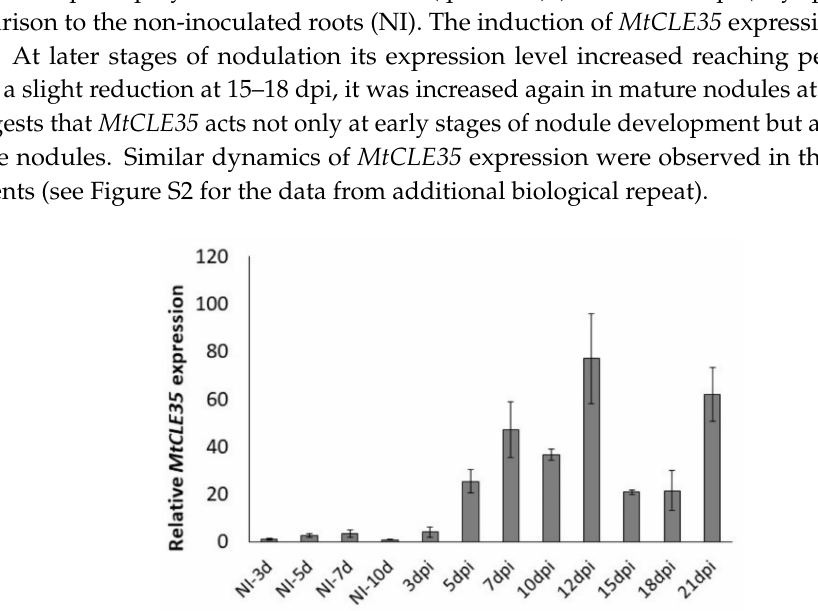
Figure 2. The expression levels of the MtCLE35 gene at di ff erent days post inoculation (dpi) in comparison to the non-inoculated roots (NI). Results are mean ± standard error of the mean (SEM) of three technical repeats of one biological repeat, representative for three independent